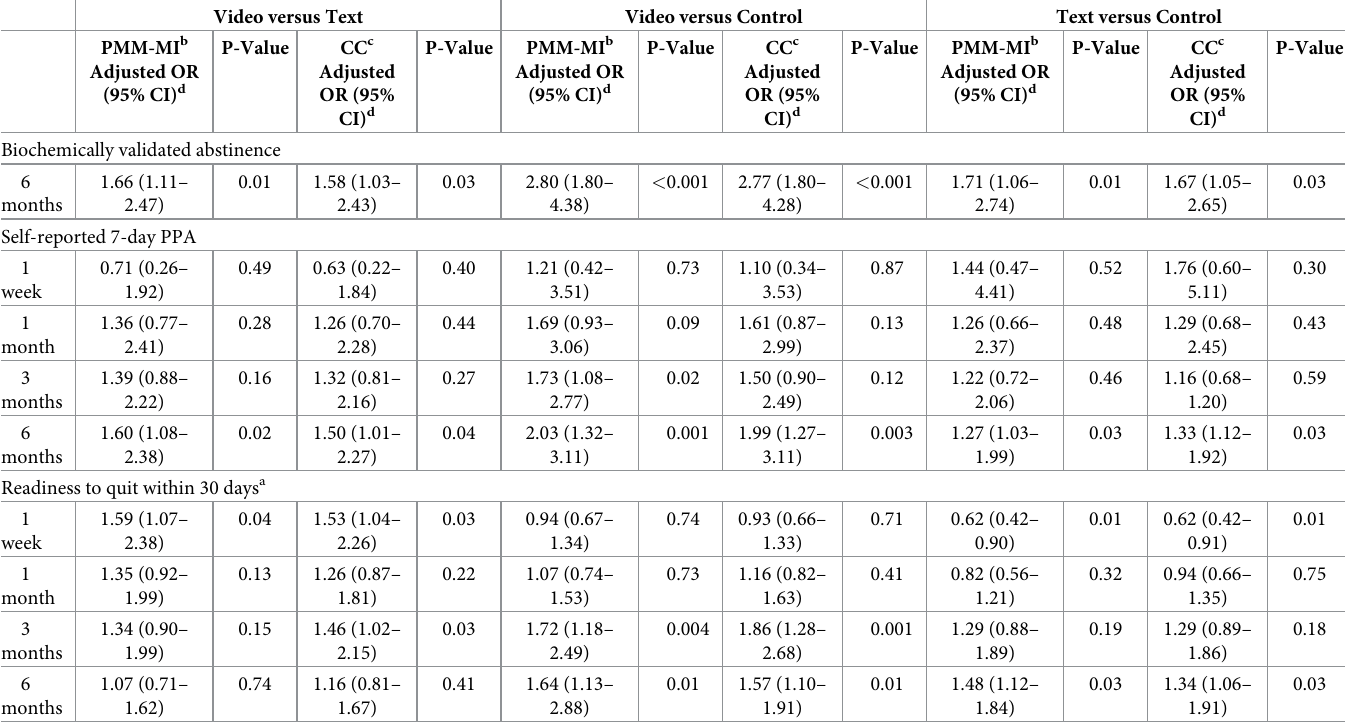
Table 5. The sensitivity analysis for primary and secondary outcomes by using PMM-MI and completed case. Video versus